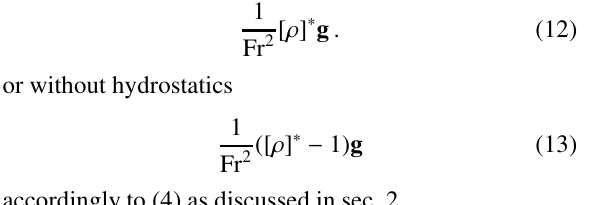
Fig. 2. Computational mesh with 2360 elements and domain boundary designation. Lines inside the domain connect quadra- ture points for degree 6 approximation inside triangular ele-